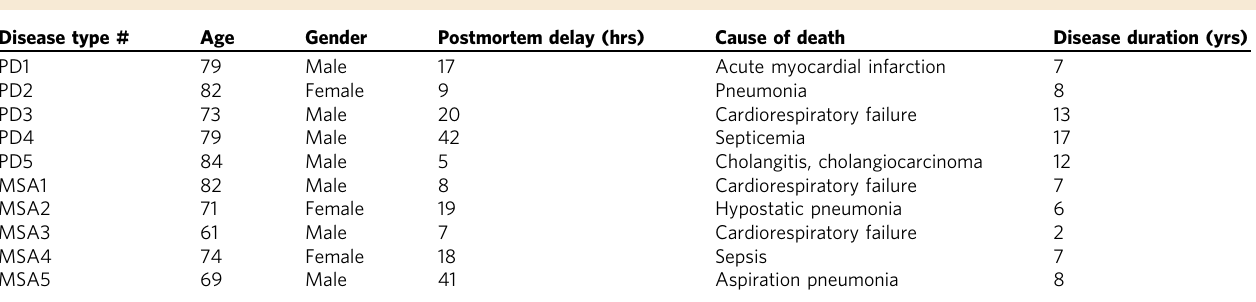
Table 1 Demographics of donor brains from α -synucleinopathy patients. Disease type